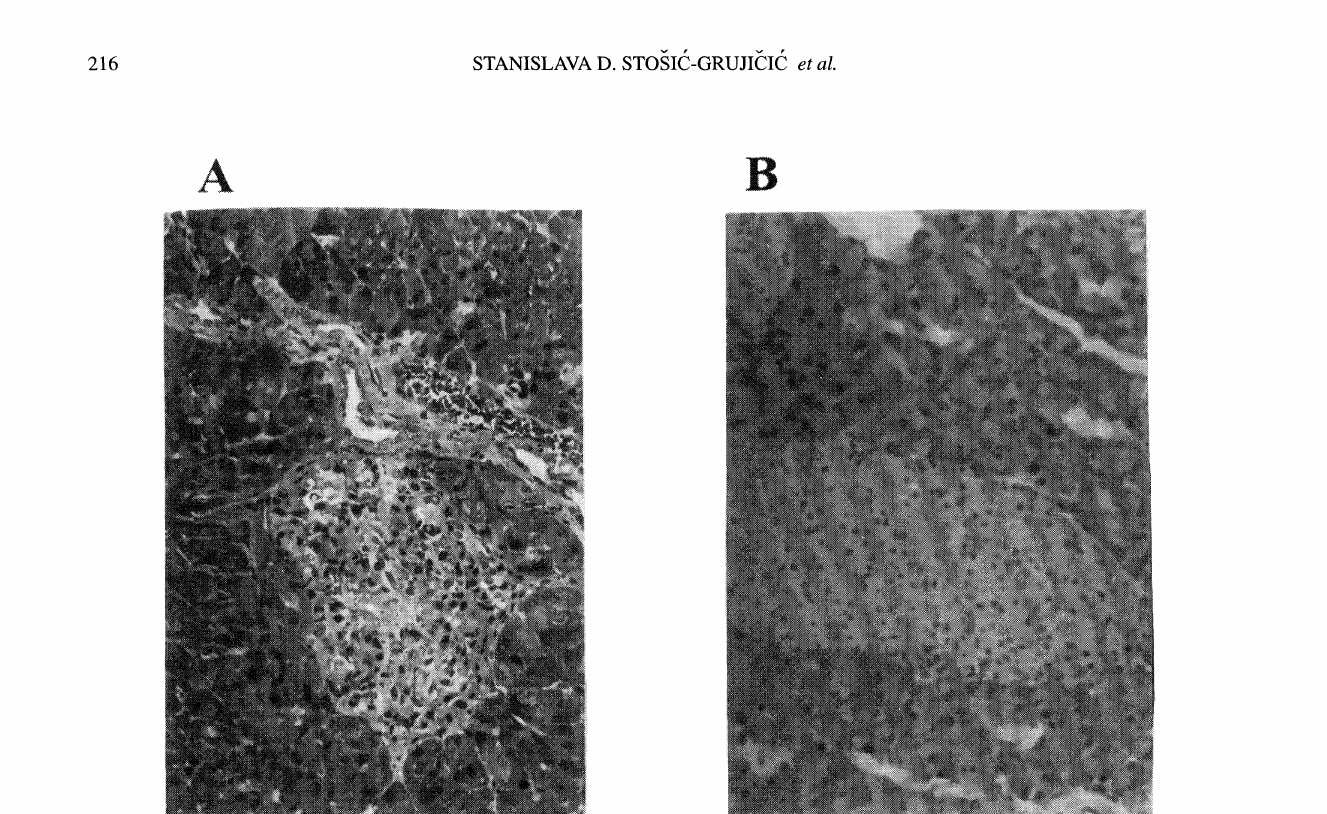
FIGURE 2 Effect of PTX treatment on the development of MLD-SZ-induced insulitis in CBA/H mice. (A) Histology of pancreatic islet by day 10 after MLD-SZ treatment (HE x 60). Note massive infiltration of the islet with the initial necrotic changes and endothelial swelling. (B) Histology of pancreatic islet by day 10 after treatment with MLD-SZ + PTX (HE x 50). Note well preserved islets without insulitis and necrosis and with normal